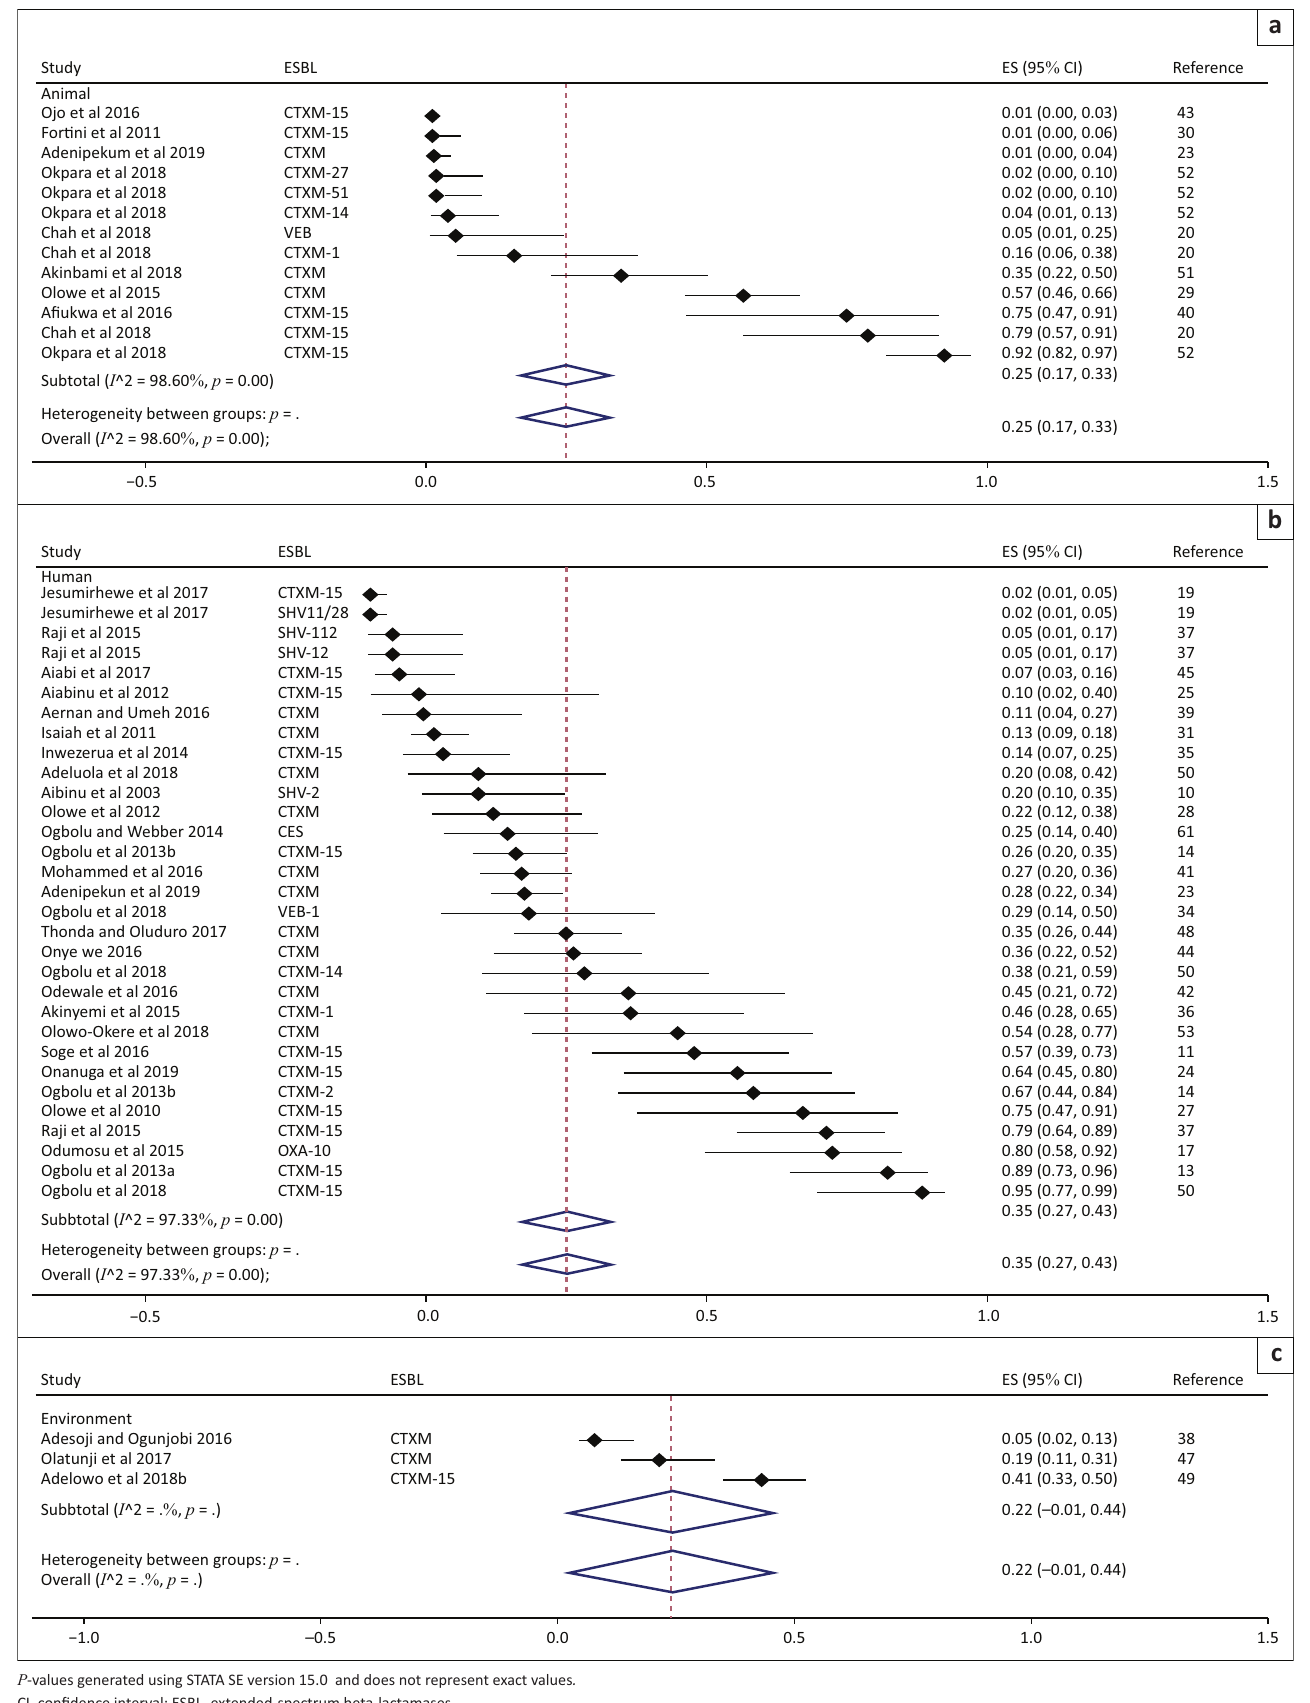
FIGURE 2: Subgroup analysis and forest plot of proportion estimates of extended-spectrum beta-lactamases for animal (a), human (b) and environmental settings (c) in Nigeria